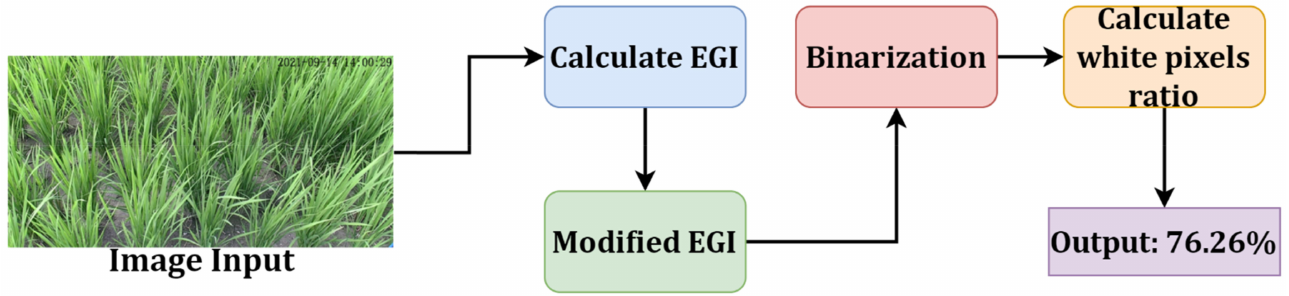
Figure 8. Flow Chart of Calculating GC